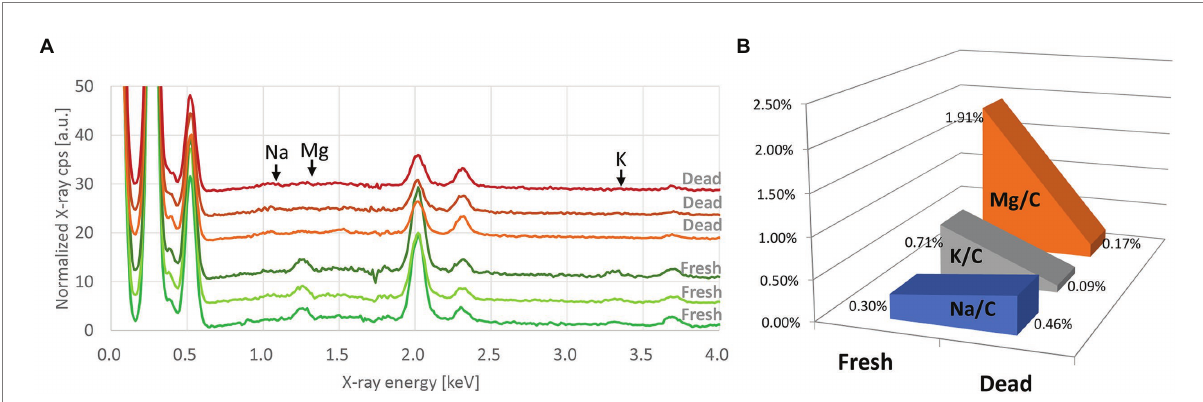
FIGURE 2 (A) Processed EDX spectra of E. coli (Q5586) at the fresh state and after exposure to 70% ethanol. Each curve represents the average of three spectra taken from the same bacterial deposition. Spectra are offset by 3. (B) Evolution of the K/C, Mg/C, and Na/C ratios between the fresh and the alcohol-killed E. coli .